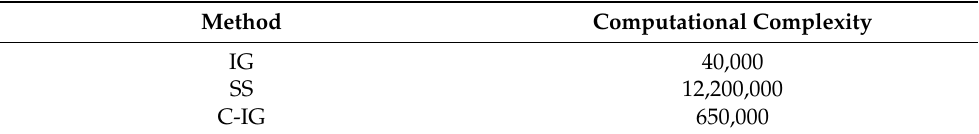
Table 2. Computational complexity of explanation methods in the UCI EEG